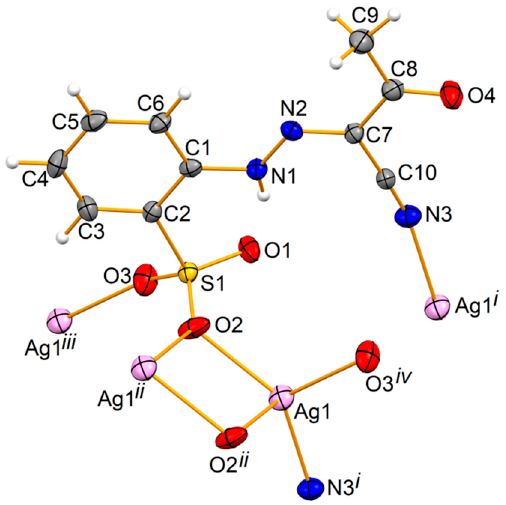
Figure 1. Ellipsoid plot of a fragment of polymer 1 , drawn at 30% probability level and with atom numbering scheme. Crystallization water molecule is omitted for clarity. Symmetry operations to generate equivalent atoms: ( i ) 1 − x,2 − y,1 − z; ( ii ) 1.5 − x,1.5 − y,1 − z; ( iii ) x, − 1 + y,z; ( iv ) x,1 + y,z.